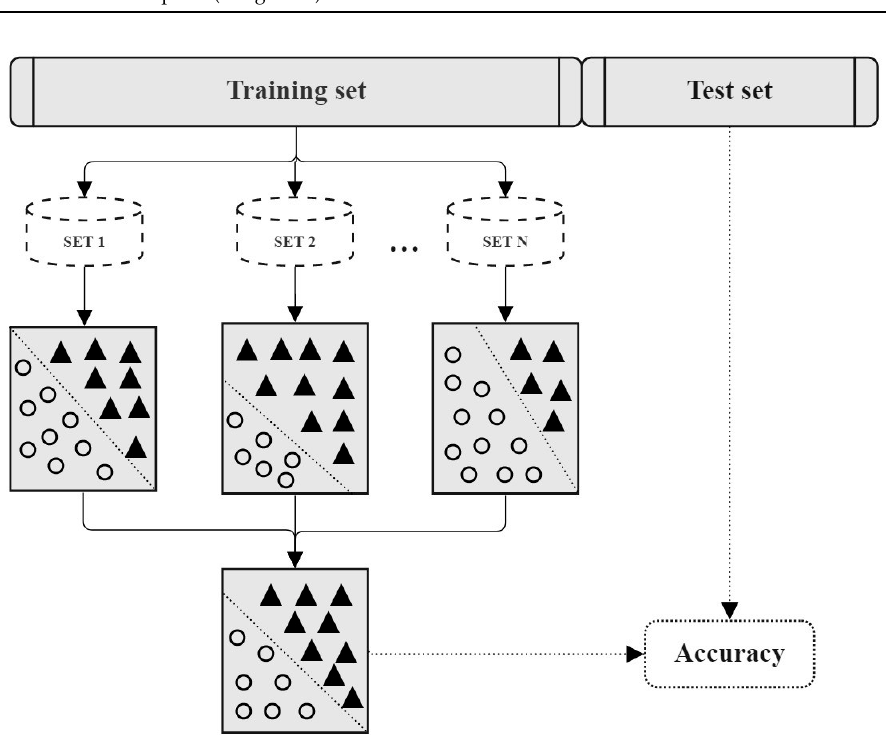
Figure 3. Diagram of the bagged model.